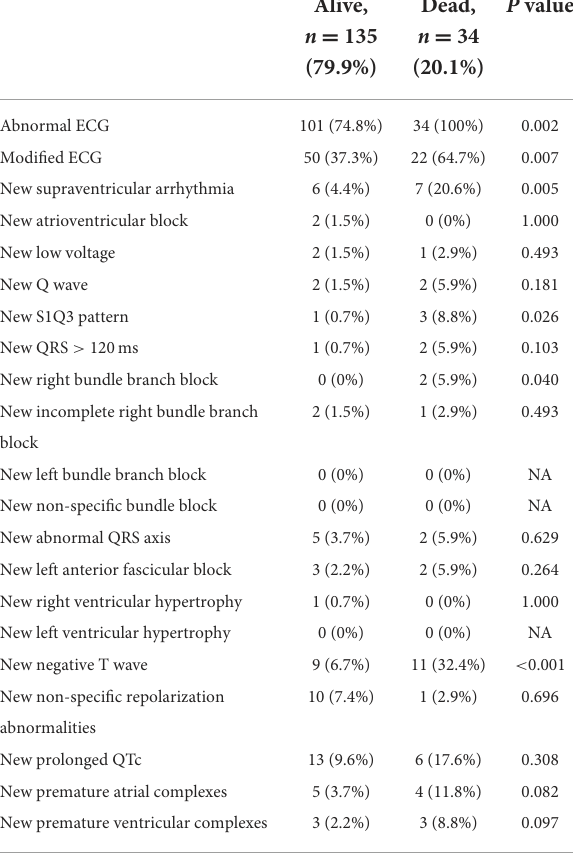
TABLE 5 Summary of multivariate analysis for identifying variables independently associated with death among patients who had a second ECG during hospitalization, n =